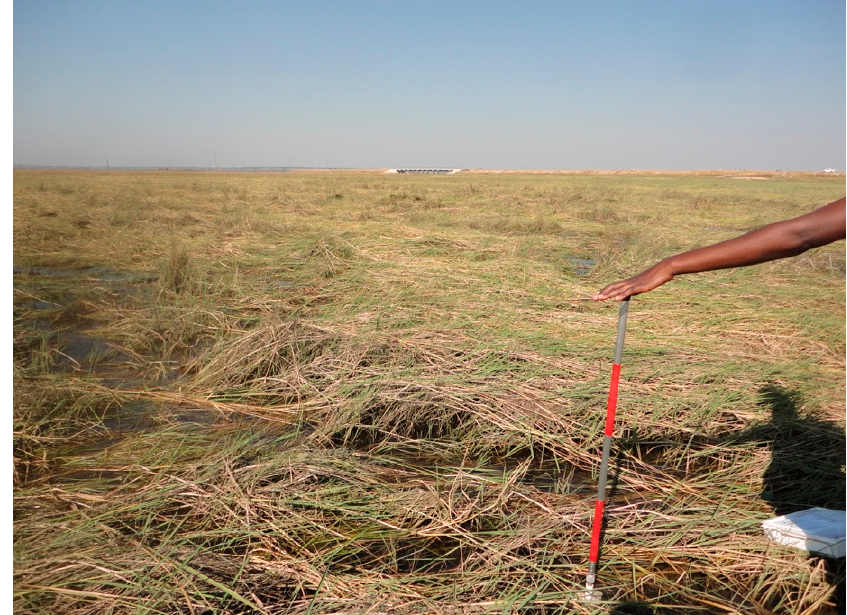
Figure 11. Example vegetated water body that was missed by the classification, characterised by matted or floating grasses. Image from June 2018 long: 23.16, lat: − 15.36. Ranging pole with 5 × 20 cm sections from base. Water depth = 10 cm.